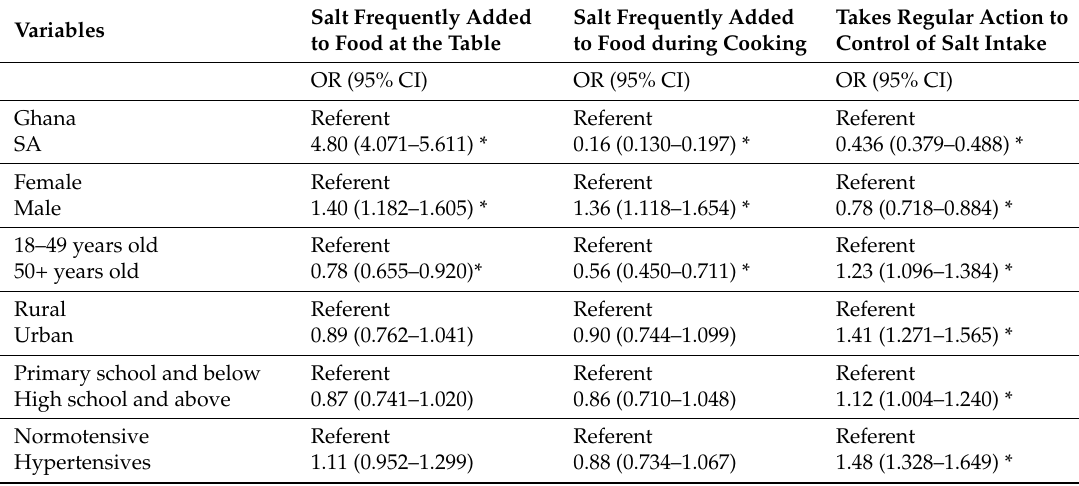
Table 3. Associations between sociodemographic variables and salt behaviours of adults in Ghana ( n = 6746) and South Africa ( n = 3776)—comparing the odds ratio for sub-optimal salt behaviours, SAGE Wave